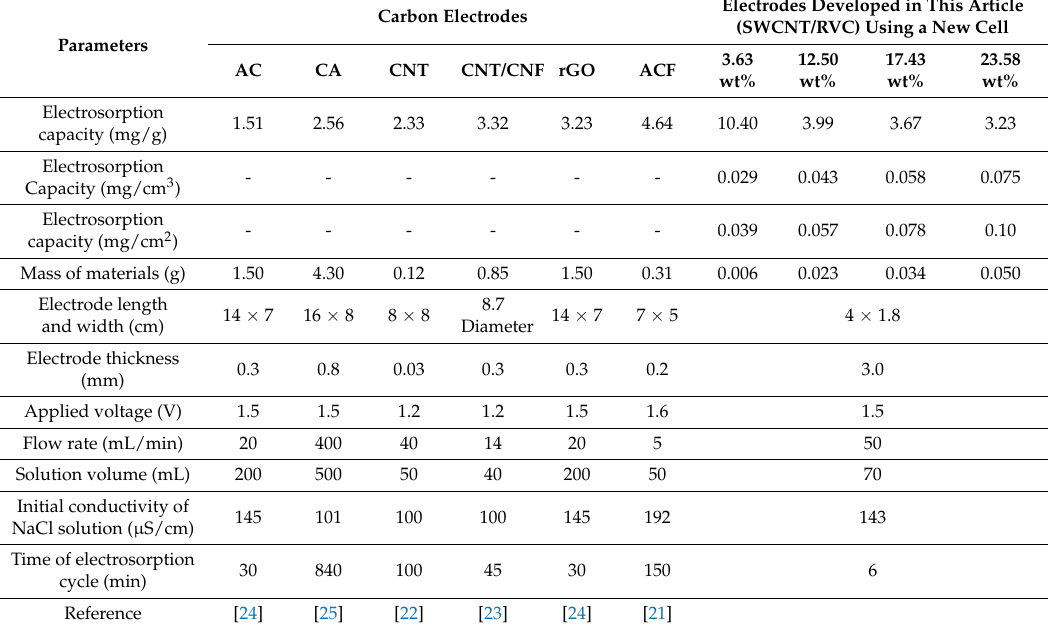
Table 7. Comparison of electrosorption capacity of various carbon electrodes and electrodes developed in this